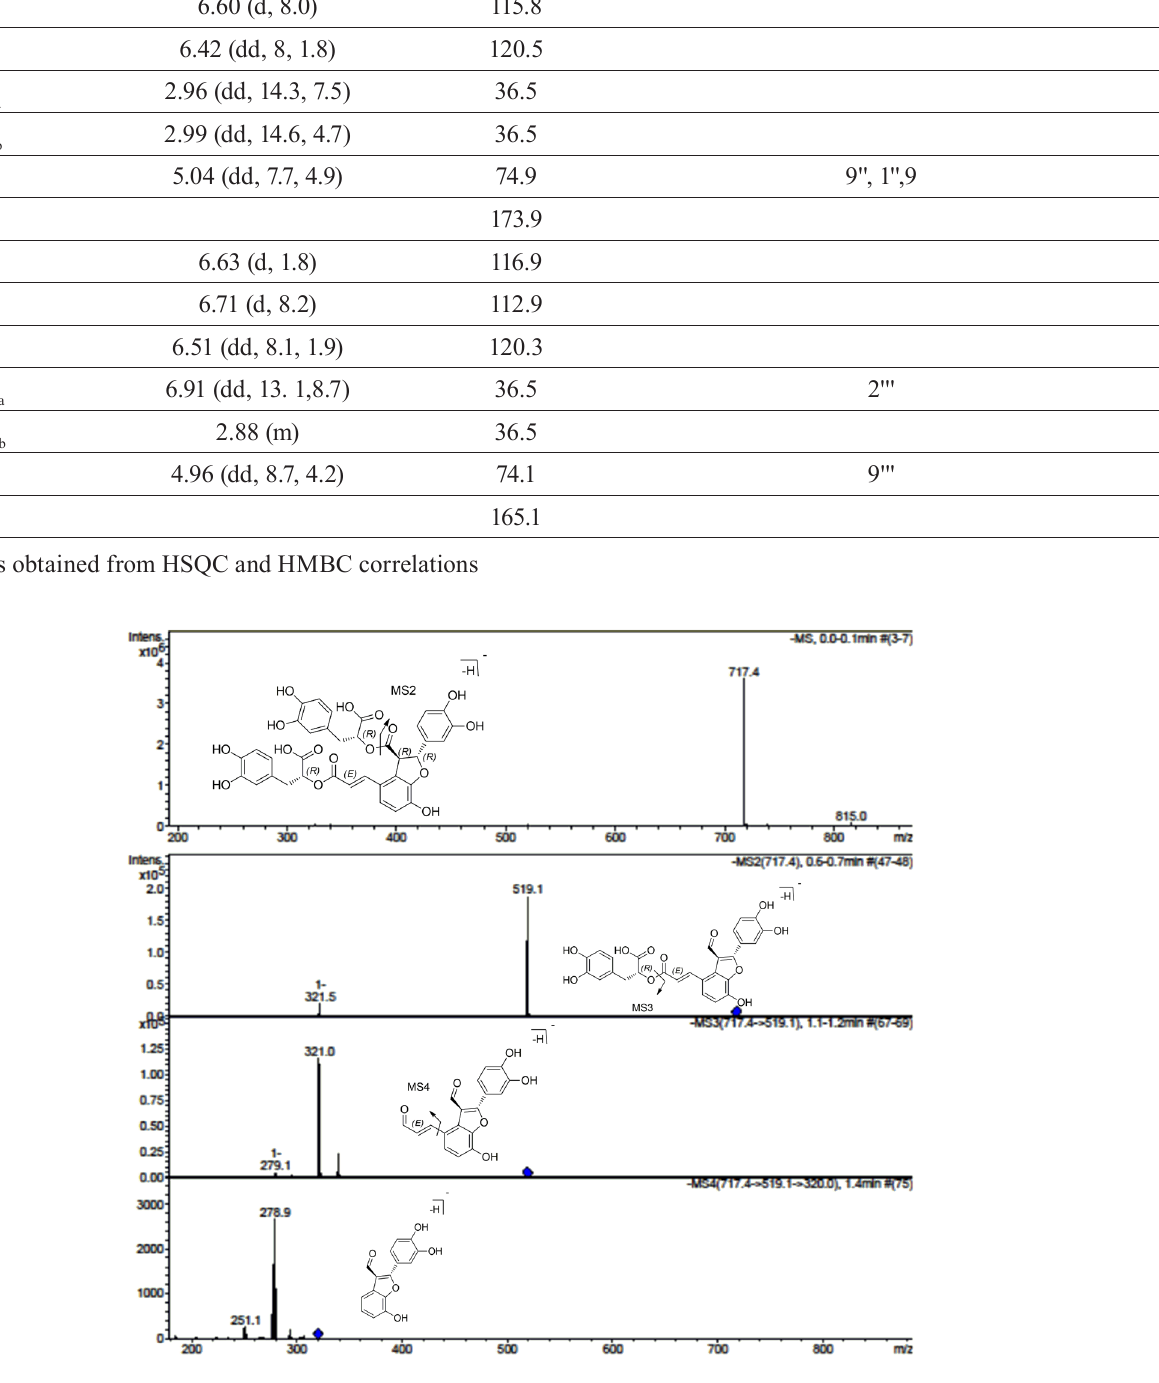
FIGURE 3 - ESI-MSn spectrum (negative ion mode) of (7’ R , 8’ R , 8’’ R , 8’’’ R )-epi-salvianolic acid B ( 16 ), and proposed fragmentation